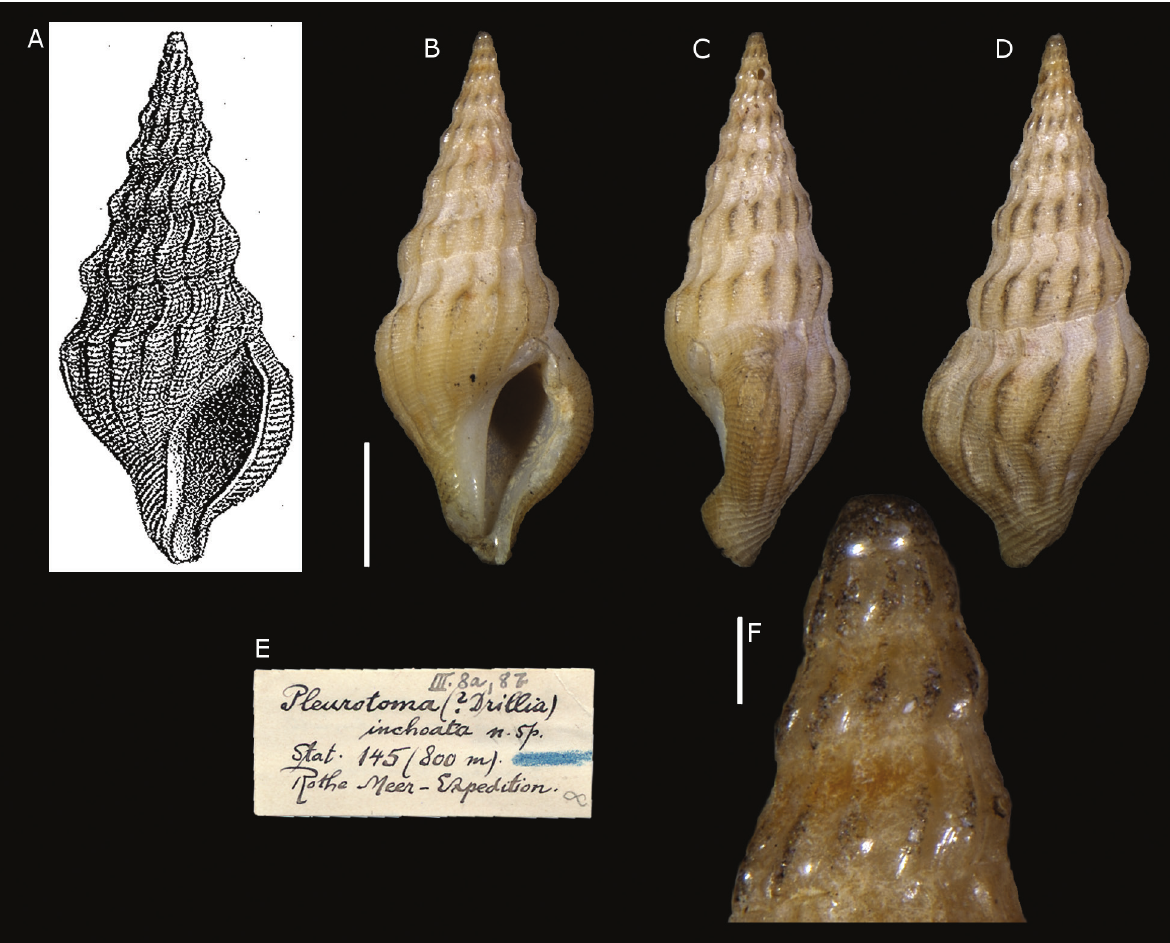
Figure 22. Pleurotoma inchoata Sturany, 1900, Station 145 (Dahlak Archipelago, Eritrea, Red Sea). A . Original figure by Sturany (1903). B–D , F . Holotype, NHMW 84251: front ( B ), right side ( C ), back ( D ), protoconch ( F ). E . Original holotype label. Scale bars: B–D : 5 mm, F : 0.5 mm.